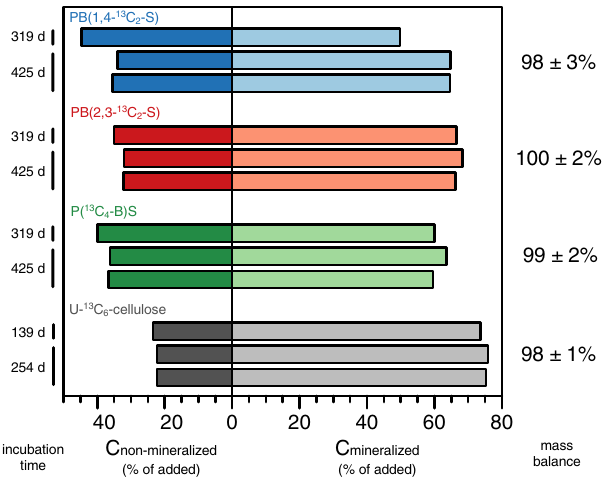
Fig. 4 | Residual amounts of poly(butylene succinate) (PBS) extracted from soils at the end of the incubations. Amounts of PBS extracted from soils (i.e., C polymer residual ) expressed in percent of the total non-mineralized amount of PBS- added 13 C (i.e., C non-mineralized ) remaining in the soils at the end of the incubations. Results are shown for triplicate incubations of the three 13 C-labelled PBS variants (i.e., PB(1,4- 13 C 2 -S), PB(2,3- 13 C 2 -S), and P( 13 C 4 -B)S, shown in blue, red, and green, respectively). For each soil from the incubations, residual PBS was quanti fi ed in three soil subsamples; open symbols represent results from each individual extracted subsample, while colored bars and error bars depict the mean ± one standard deviation of these triplicate